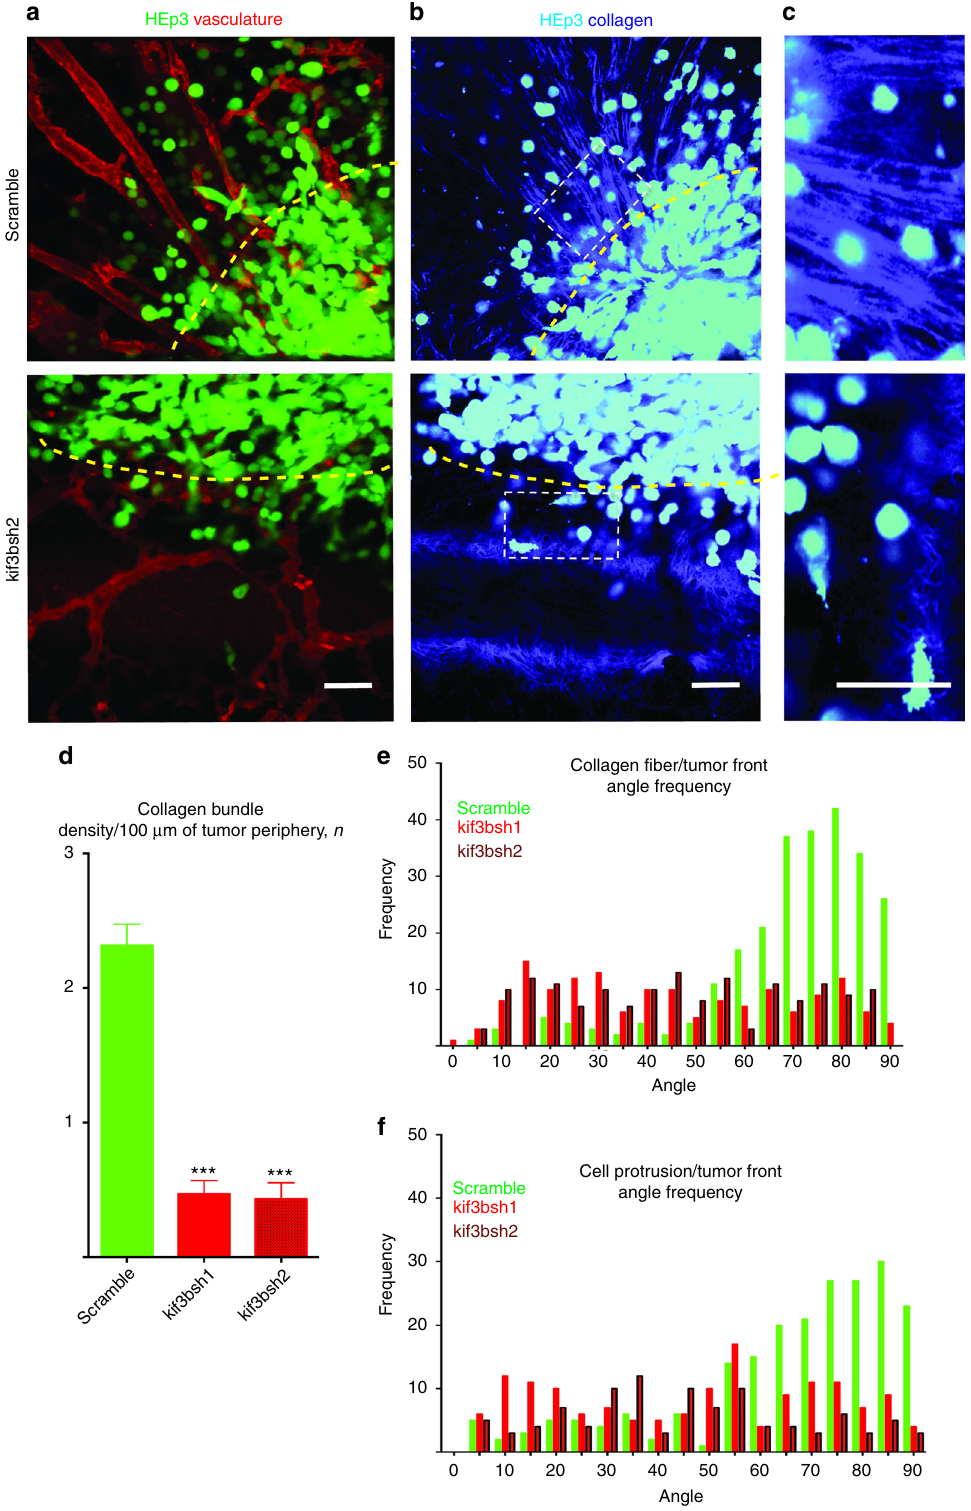
Fig. 4 Kif3b is required for collagen fi ber alignment at the tumor front in vivo. a Primary tumor fronts of HEp3 control (upper panel) and HEp3 shRNA2 Kif3b (lower panel) tumors as visualized using intravital confocal microscopy. b Collagen fi ber organization (SHG) along the HEp3 control (upper panel) and shRNA2 HEp3 Kif3b (lower panel) tumor fronts, see also Supplementary Movie 5. c Higher magni fi cation images of the collagen fi ber network from within white dashed rectangles in ( b ). Yellow dashed lines delineate tumor borders. d Quanti fi cation of collagen bundle density at the invasive fronts of control and shRNAs1/2 Kif3b HEp3 tumors. e Quanti fi cation of collagen fi ber alignment at the invasive fronts of control and shRNAs1/2 Kif3b HEp3 tumors. f Quanti fi cation of cancer cell protrusion orientation at the invasive fronts of control and shRNAs1/2 Kif3b HEp3 tumors. Scale bars = 100 μ